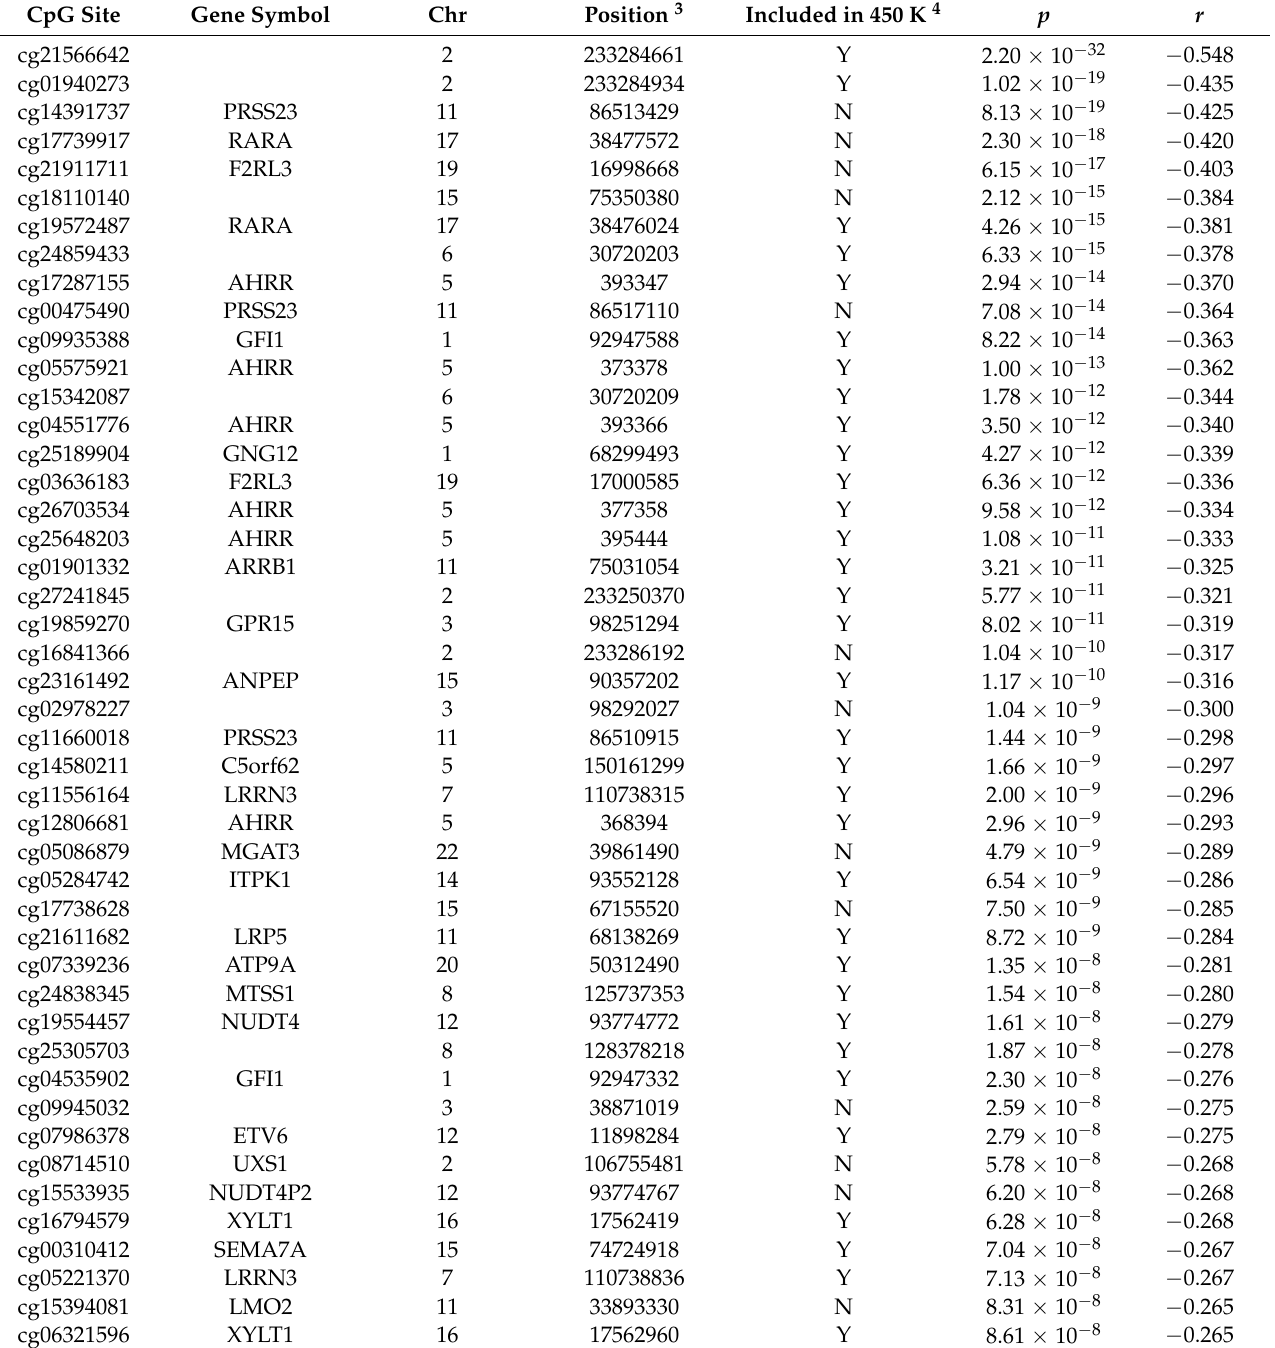
Table 2. Top differentially methylated CpGs for smoking status (5 levels) 1 ranked by smallest p -value after multivariate adjustment 2